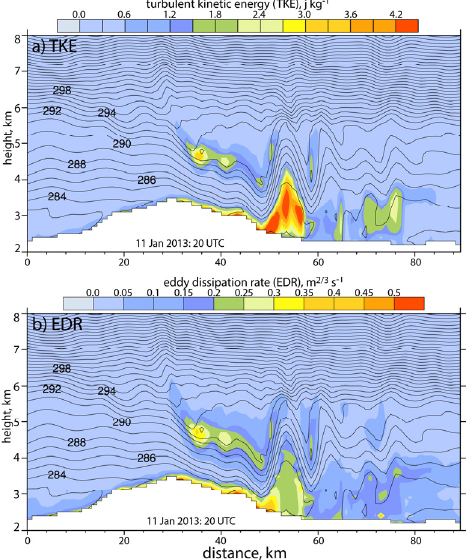
Figure 6. As in Figure 5, but showing zonal wind speed.